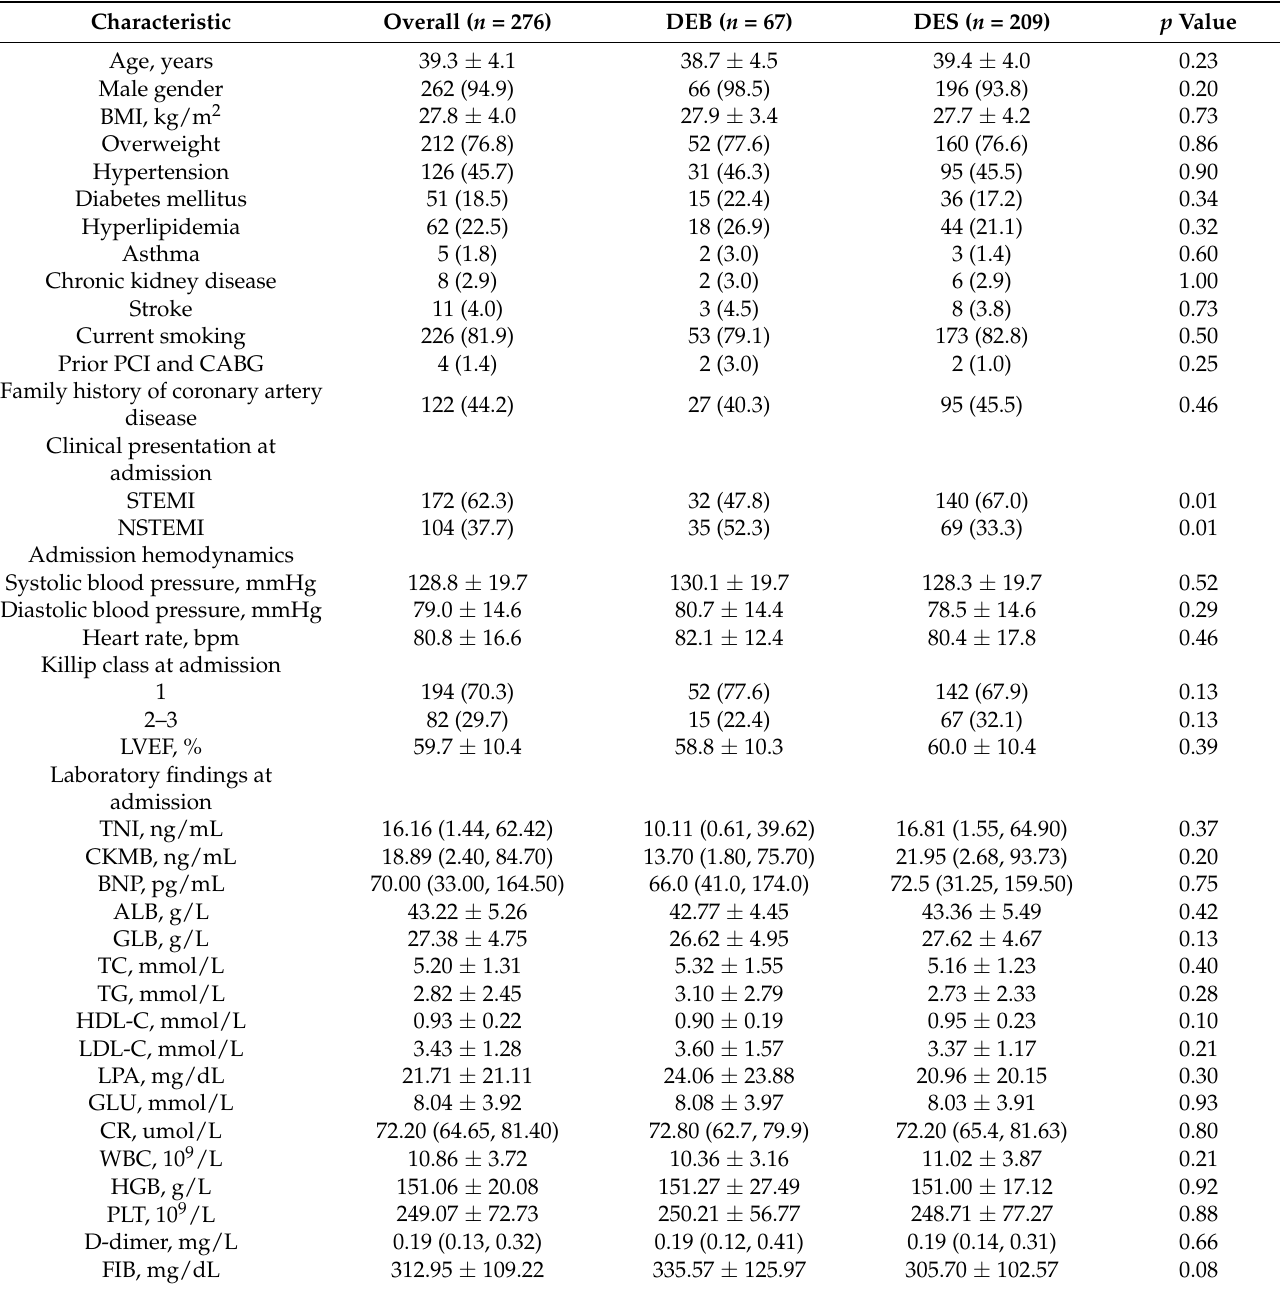
Table 1. Baseline and clinical characteristics of